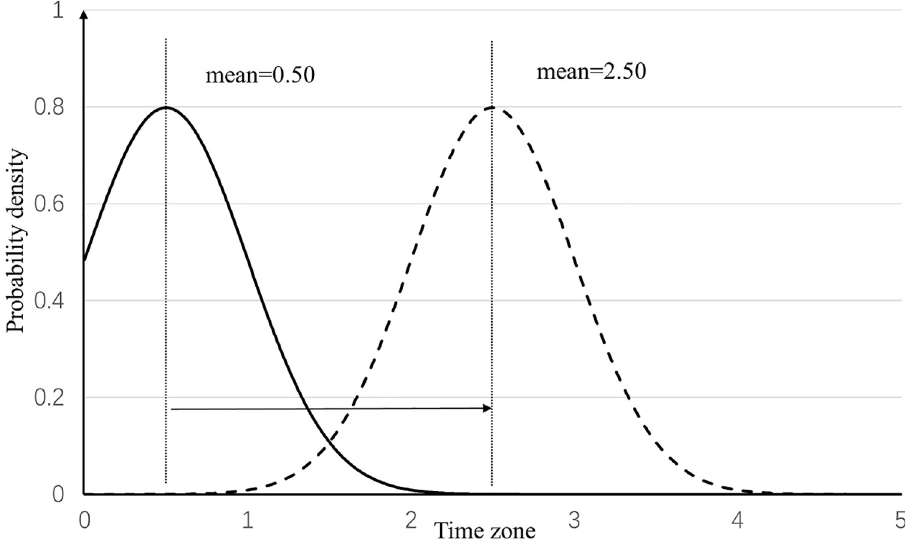
Fig 6. The diagram of information pick